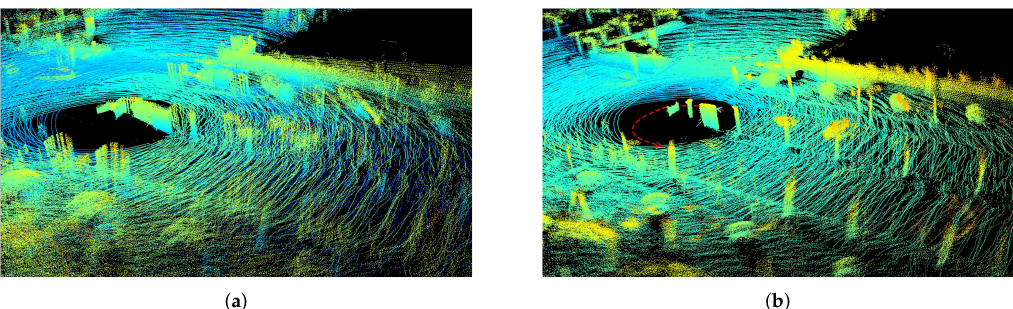
Figure 8. The 3D reconstruction result when the vehicle turns around at the intersection. The left ( a ) is the result before hand–eye calibration, and the right ( b ) is the result after hand–eye